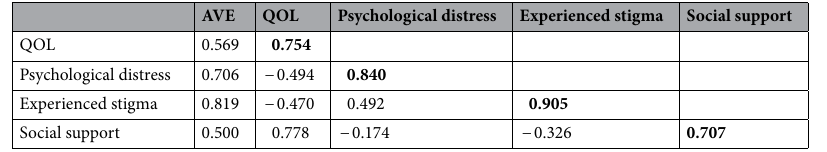
Table 4. Validity analysis of the constructs. QOL quality of life, AVE average of variance extracted. The bold values on the diagonal in the table are √ AVE s, and the values underneath the bold value represent the Pearson correlation coefficients between the constructs.